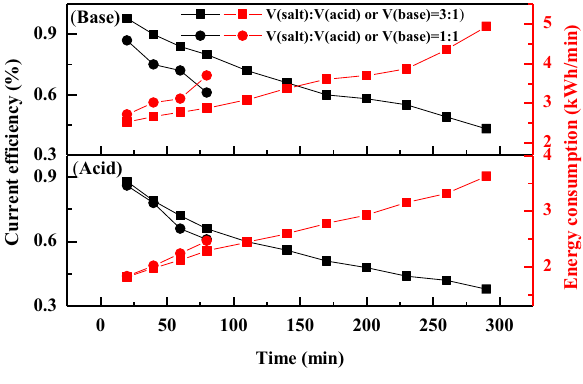
Fig. 12 The influence of different feed volume on efficiency and energy consumption